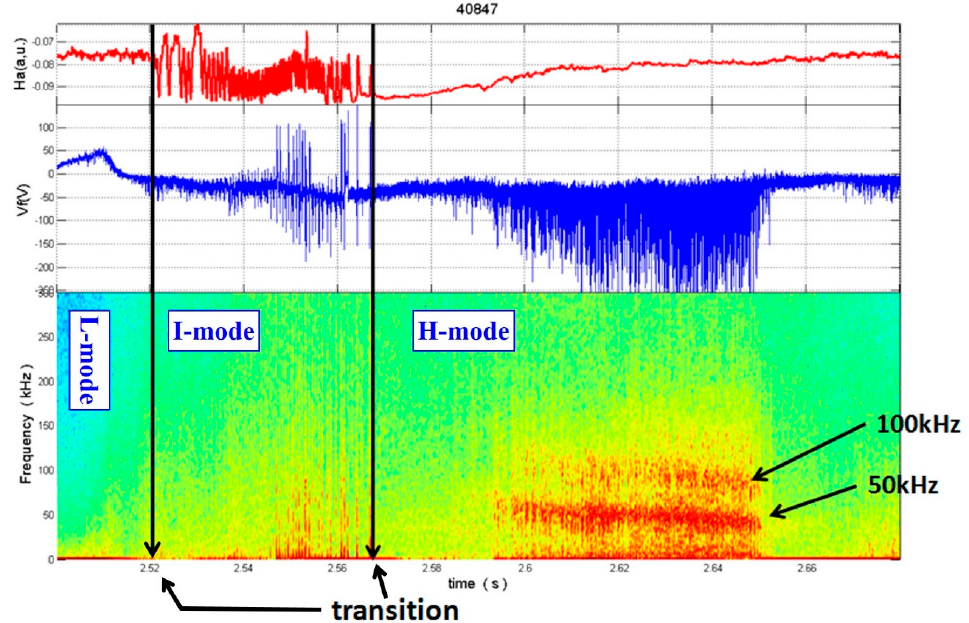
Figure 7. From top to bottom: Temporal evolutions of the H α line intensity (red line) and the floating potential (blue line) measured with the three-pin probe head very close to the LCFS, and of the spectrum of floating potential fluctuations. The two black vertical arrows show the transitions from L-mode (low mode) to I-mode (intermediate mode) and from I- to H-mode (high mode), respectivly.